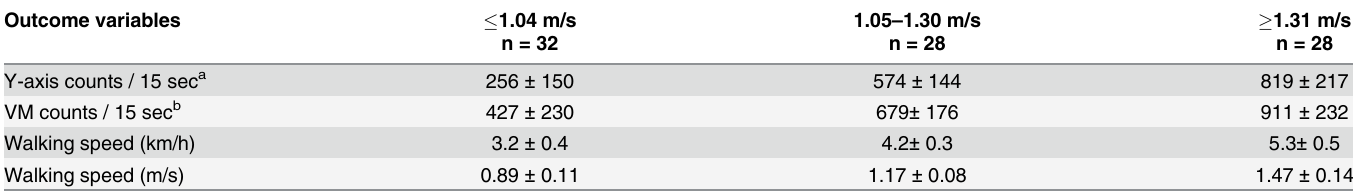
Table 2. Counts and walking speed per speed intervals.